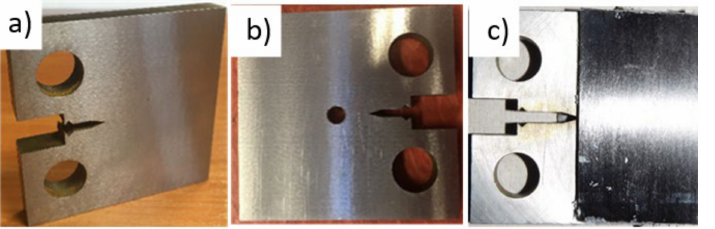
Figure 4. Real specimens devoted to the experimental campaign; ( a ) base metal compact tension (CT), ( b ) specimen after crack growth test—with drilled hole—stope hole technique, ( c ) full-face one-side CFRP